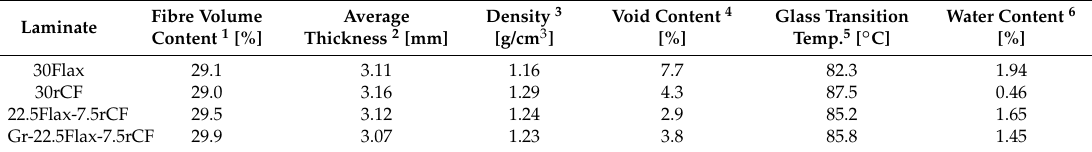
Table 2. Measured and calculated physical properties of the cured monolithic